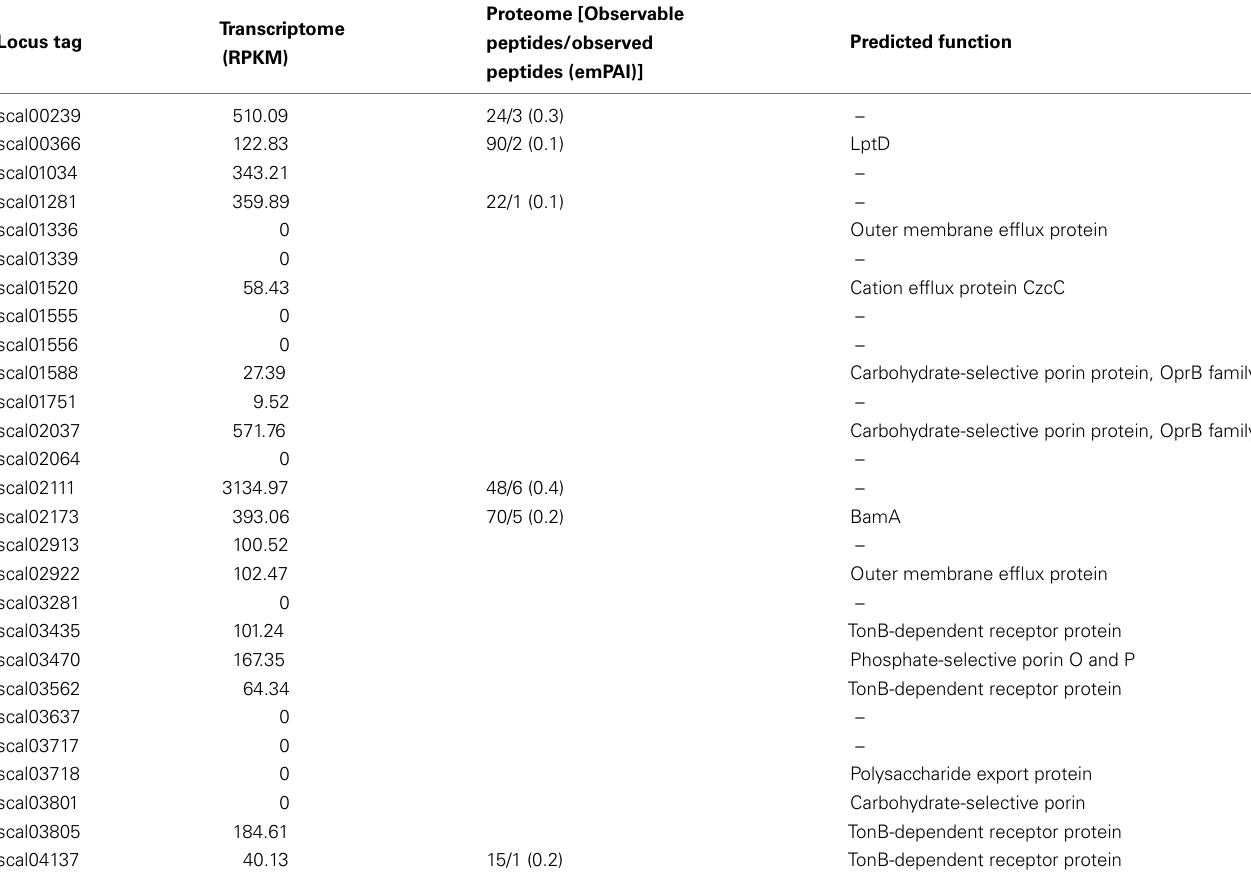
Table 4 | Gene and protein expression of outer membrane proteins in anammox Planctomycete “Candidatus Scalindua profunda.”